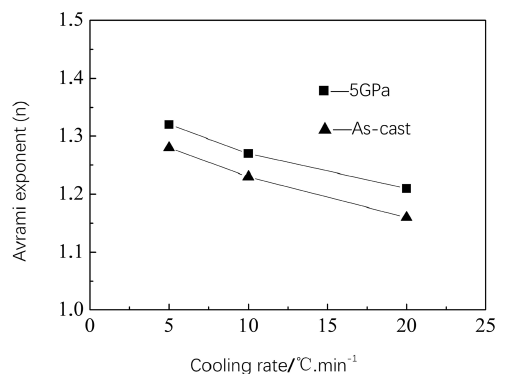
Fig. 9 - Relationship between the heating rate and Avrami exponent of Cu-Al